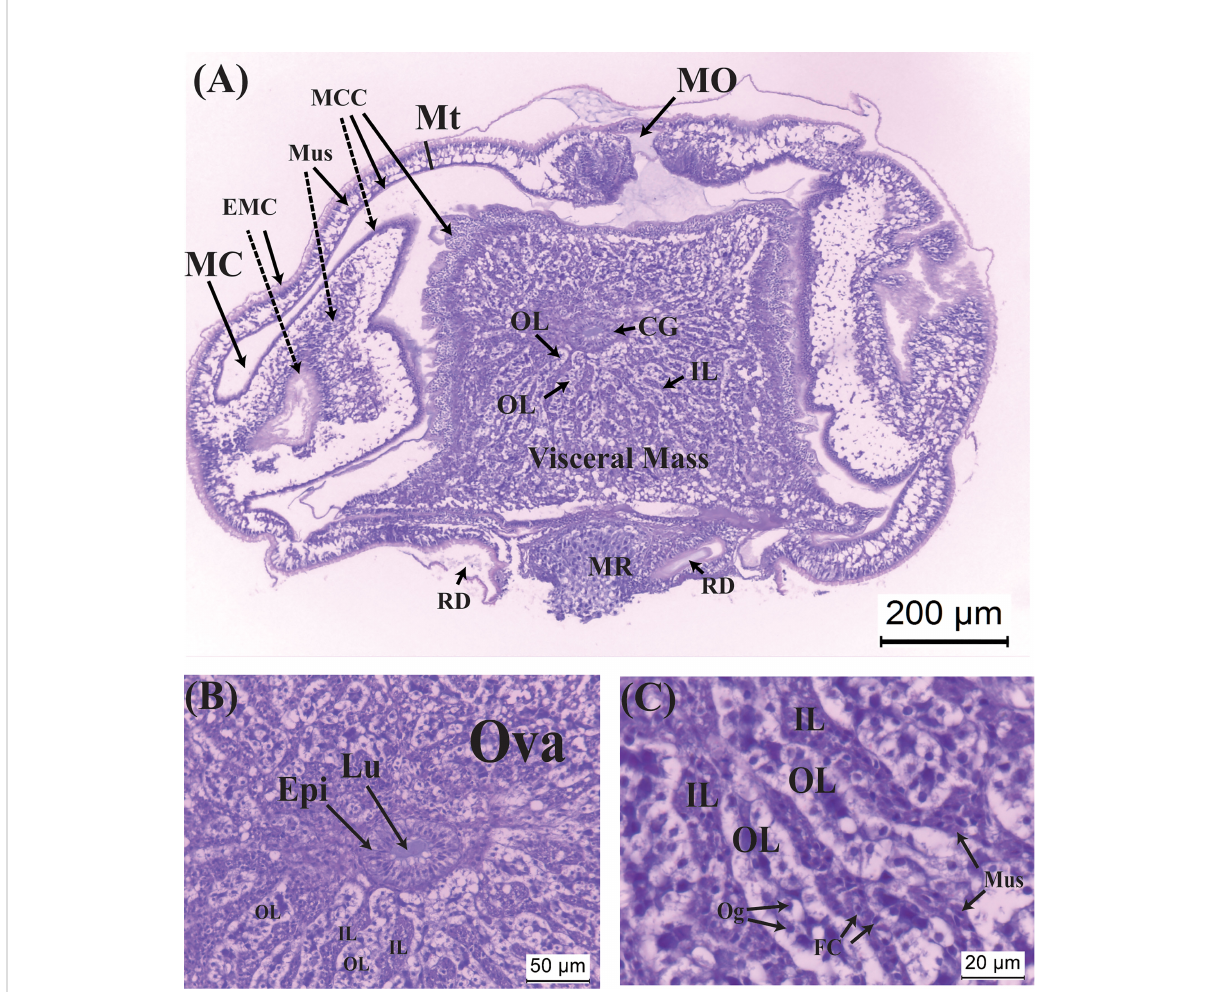
FIGURE 2 Histological sections of the virgin externa of Polyascus planus parasitizing the thukuhar shore-crab ( Metopograpsus thukuhar ). (A) A virgin externa, harvested within 12 hours of emergence, with its (B) nascent colleteric glands, and (C) ovary, which consists of ovarian lobes and inter- lobular tissues. Note that in (A) the lateral sides of the mantle invaginate toward the mantle cavity, presumably because the mantle cuticle is still soft. Dashed lines point to the invaginated areas of the mantle. CG, colleteric gland; EMC, external mantle cuticle; Epi, epithelial cells; FC, follicular cell; IL: interlobular tissue; Lu, lumen of the colleteric gland; MC, mantle cavity; MCC, mantle cavity cuticle; MO, mantle opening; Mt, mantle; Mus, muscle cell; MR, male receptacle; Og, oogonium; OL, ovarian lobe; Ova, ovary; RD, receptacle